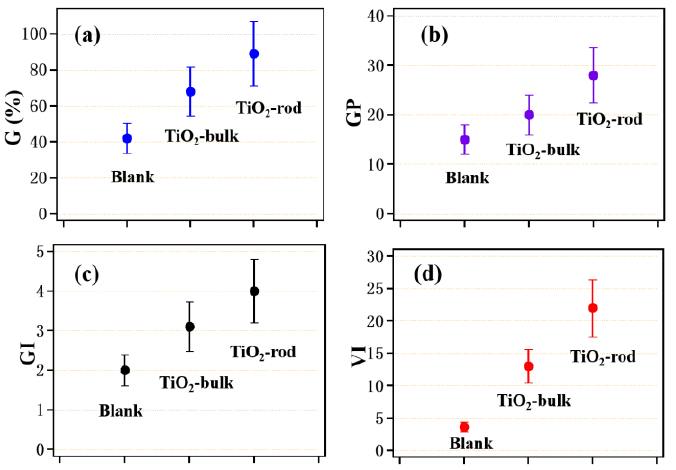
Figure 3. Germination rate ( a ); germination potential ( b ); germination index ( c ) and vigor index ( d ) of camphor seed soaked with liquid bulkTiO 2 and rod TiO 2 (concentration of 100 mg/L).